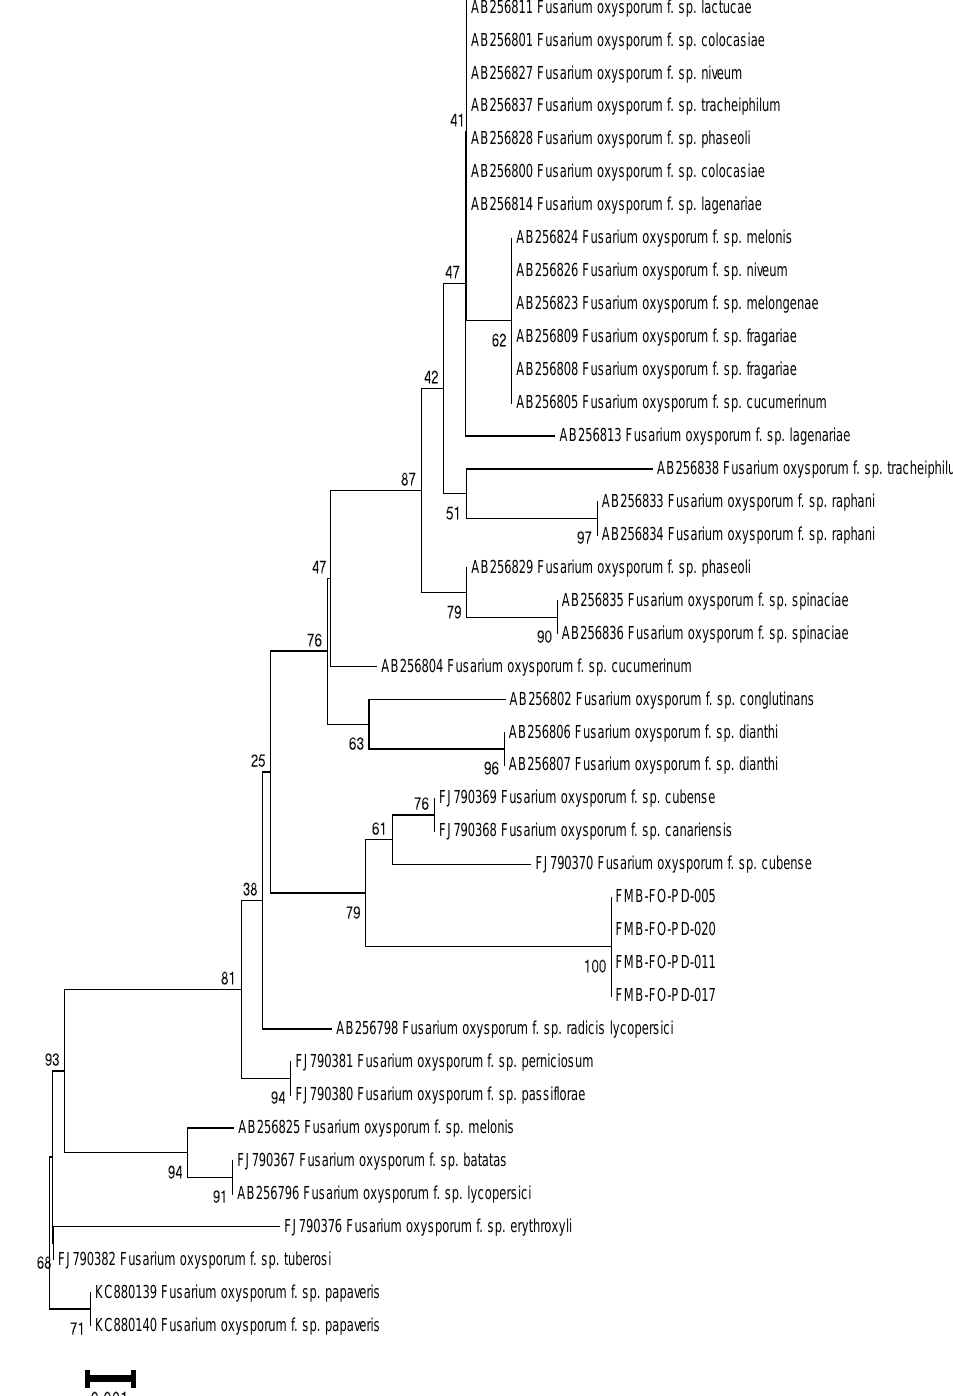
Figure 4. Phylogenetic tree based on the Polygalacturonase gene (Pgx4), using MEGA6.06 software under Neighbor-Joining (NJ) analysis, displayed a distinct and separate clade of the F. oxysporum isolates from other forma specialis with 100% bootstrap support.